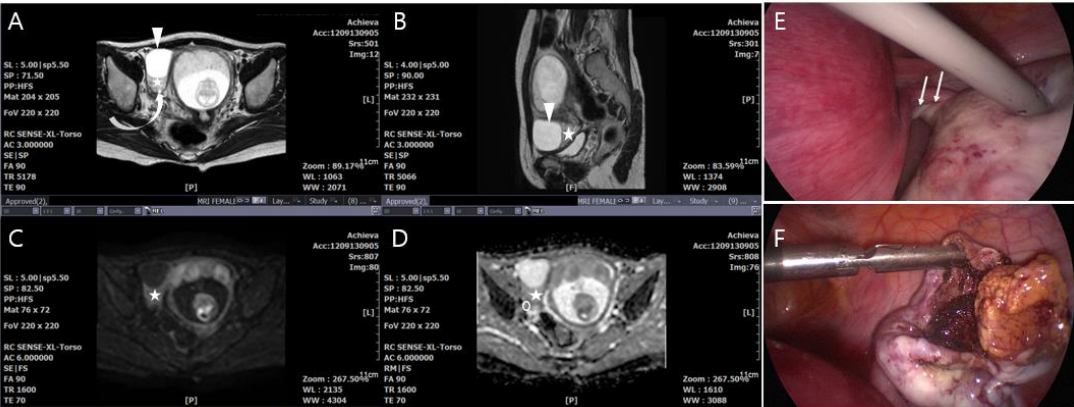
Figure 2. A 30-year-old pregnant woman (8 weeks) with acute adnexal torsion without hemorrhagic infarction in the cystectomy and detorsion group. ( A ) and ( B ) Transaxial T2-weighted single-shot turbo spin-echo MR images show hyperintense swollen ovarian medullary stroma (star) and prominent cortical follicle (curved arrow) in torsed enlarged right ovary; 3.5 cm sized unilocular cystic mass (arrowhead) in the normal-appearing ovary was pathologically confirmed as a corpus luteal cyst. ( C ) Transaxial diffusion-weighted MR image shows hyperintense swollen ovarian medullar (star). ( D ) Apparent diffuse coefficient (ADC) value indicating the region of interest (ROI) was 1.83 ± 0.11 × 10 −3 mm 2 /s in the ovarian medulla (star) and 1.57 ± 0.14 × 10 −3 mm 2 in the ovarian cortex (circle), respectively. ( E ) Gross appearance of the ovarian pedicle with 720° torsion (arrows) under laparoscopy. ( F ) Cystectomy and detorsion was performed by surgical methods of laparoscopy.